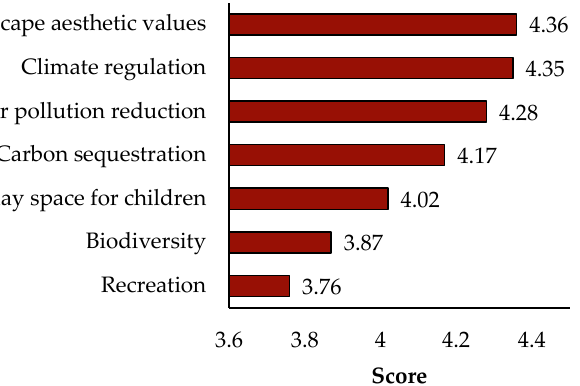
Figure 4. Average scores for the appraisal of the UGA services based on the evaluation of the participants (n = 735), using a 5-degree scale.